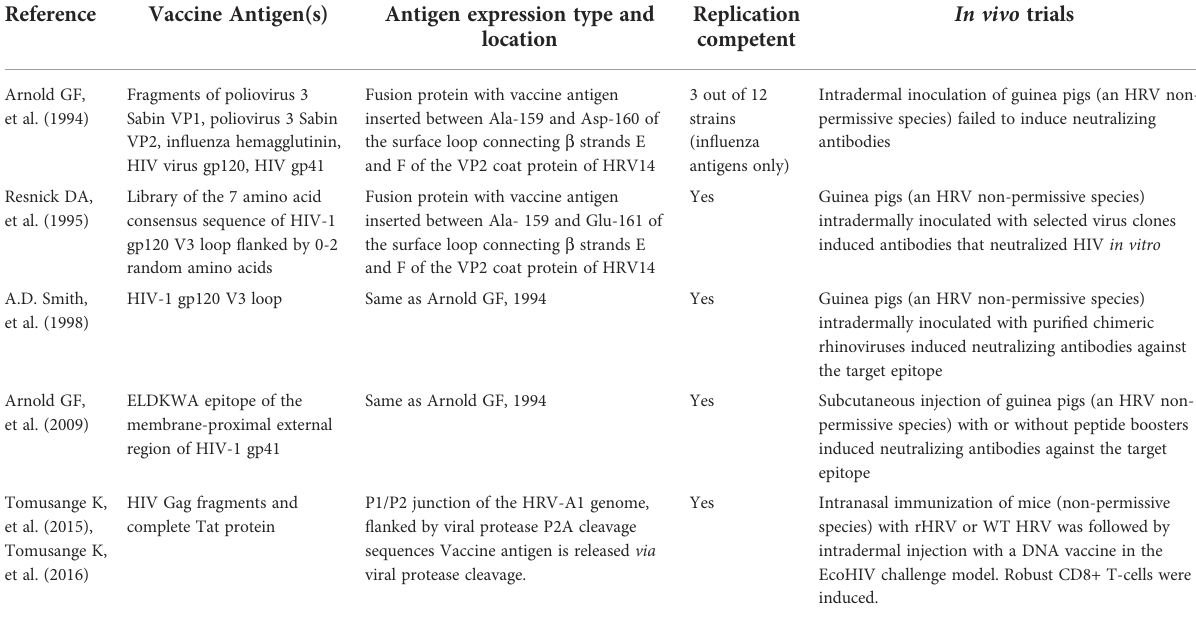
TABLE 1 Rhinovirus vaccine